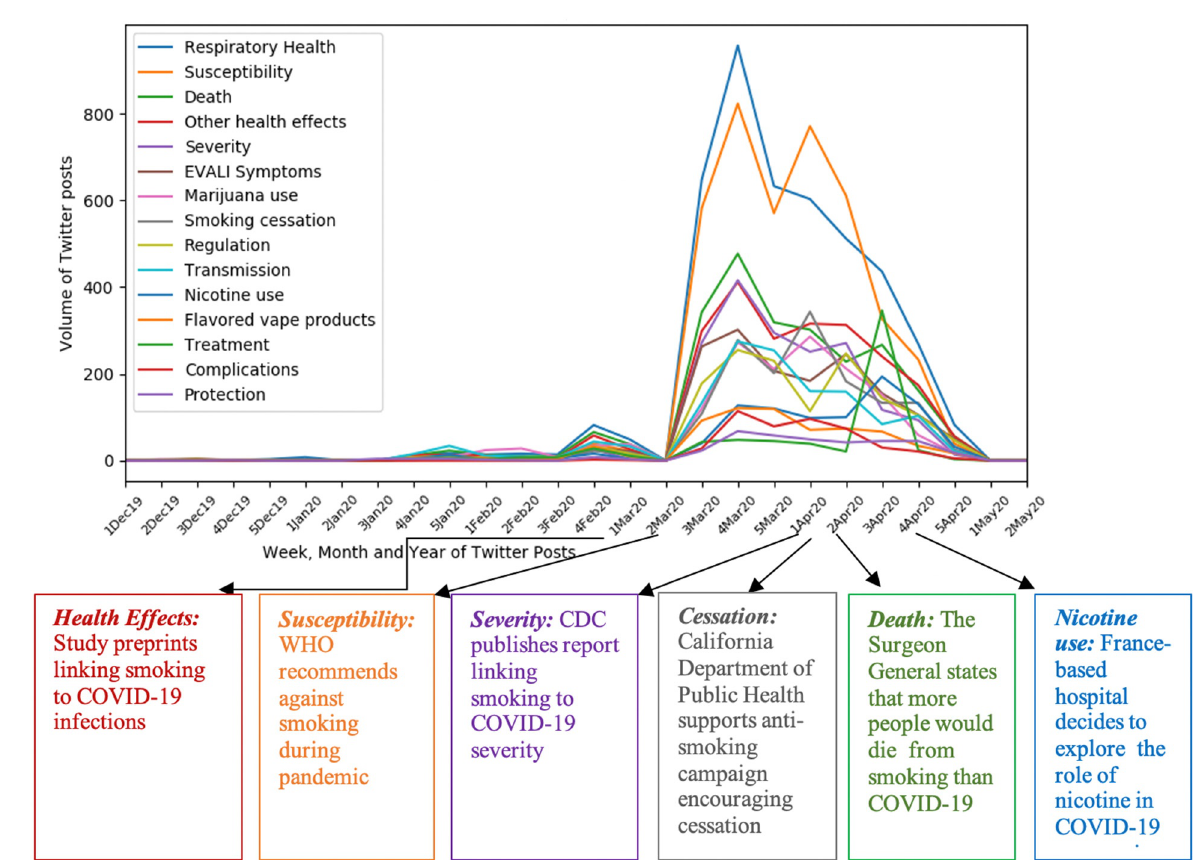
Figure 1. Temporal patterns of topics in the context of announcements from authoritative public health agencies.